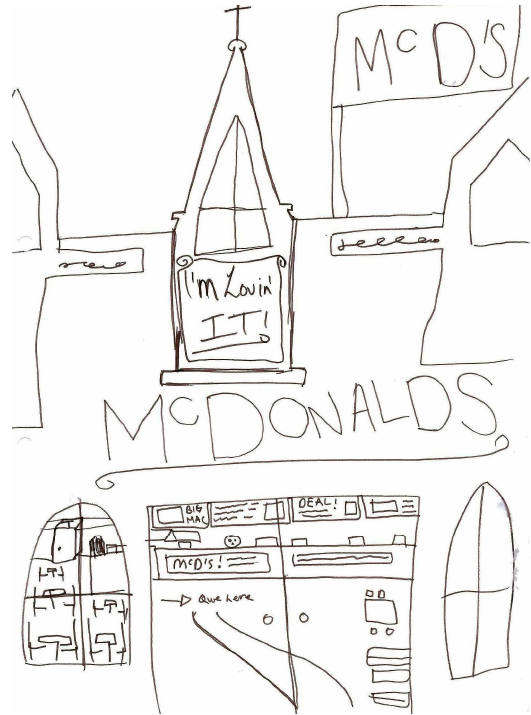
Figure 7. Reuse option ‘McDonalds’.